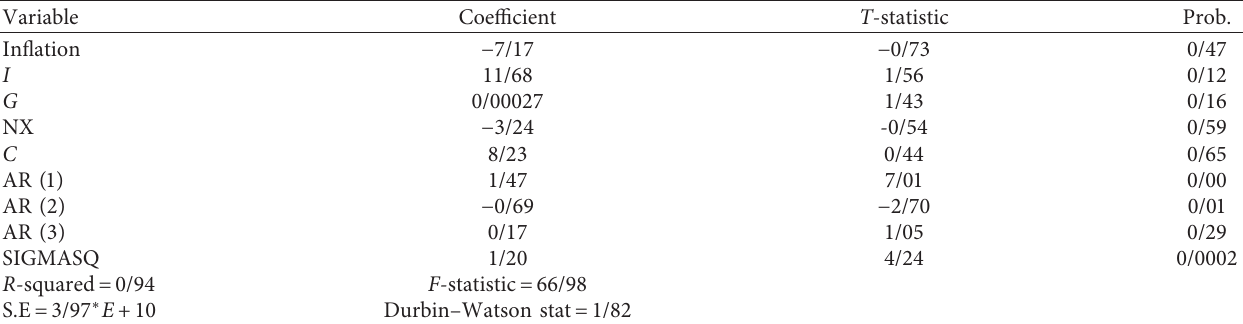
Table 5: Results of autoregression estimation scenario 1